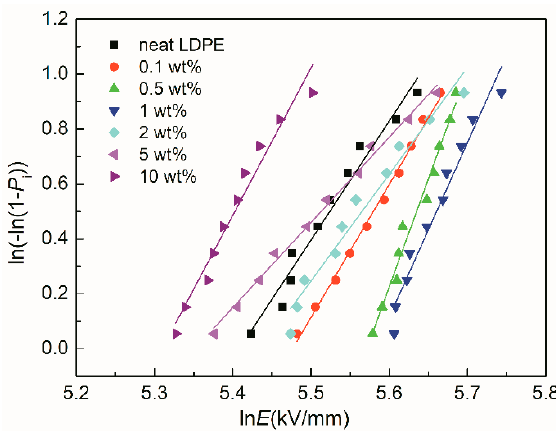
Figure 8. Breakdown results of LDPE/TiO 2 nanocomposites using the Weibull distribution method.